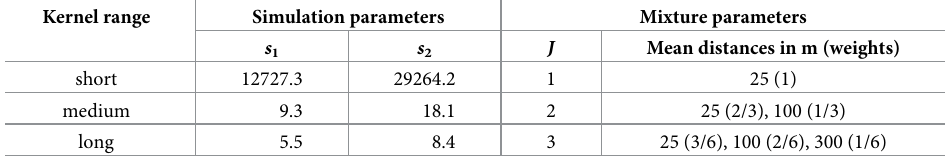
Table 1. Parameters of the three dispersal kernels used in the simulation study. Kernel range